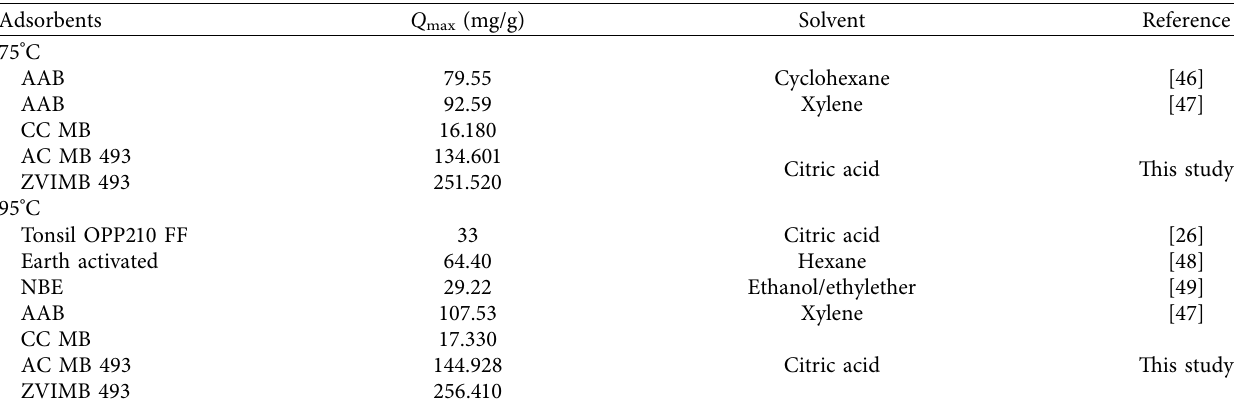
° C and 95 ° max of β -carotene at 75